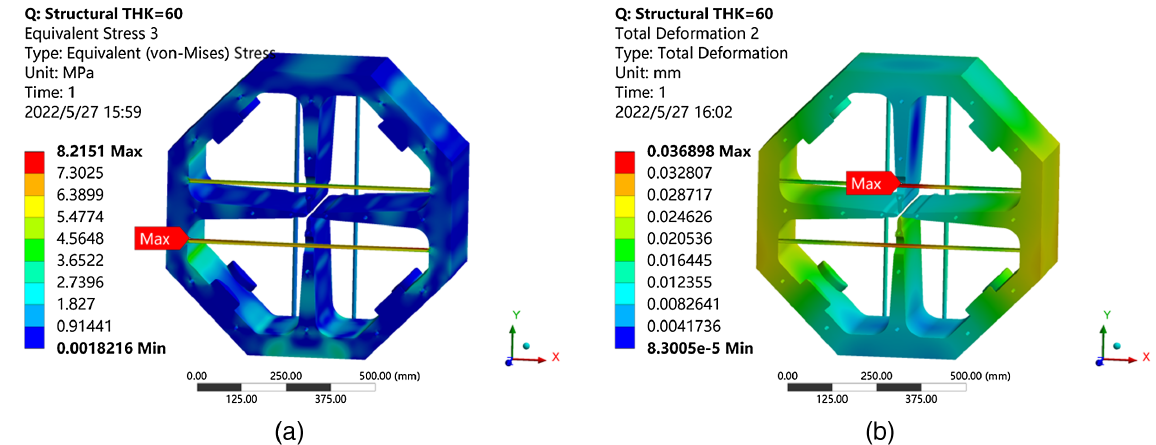
FIG. 25. Stress (a) and deformation (b) distributions of one HIAF RFQ cavity with a wall thickness of 60